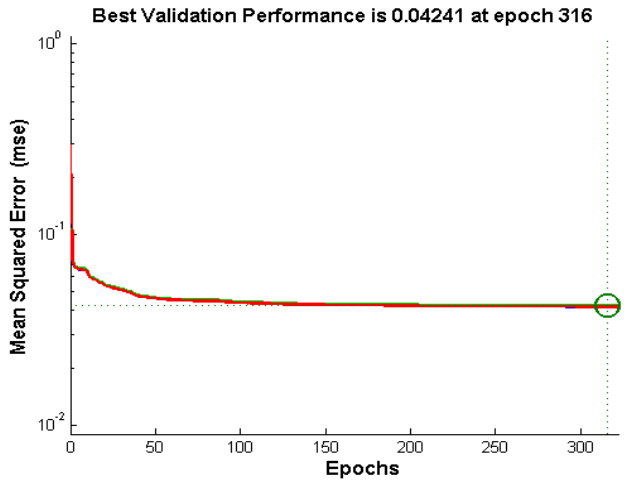
Figure 3. Training run for ANN